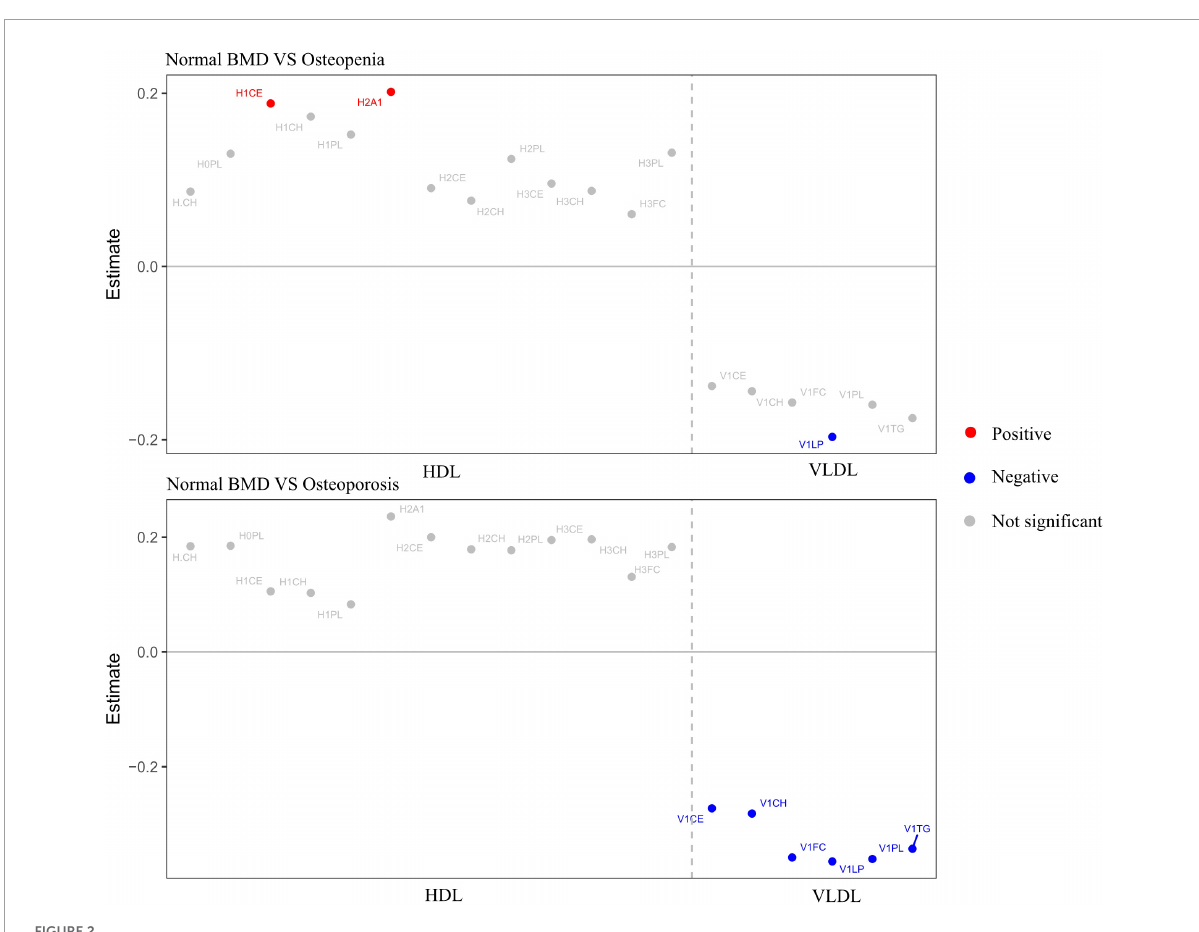
FIGURE2 Metabolites with significant differences between groups. Adjusted for age, sex, WHR, and diabetes. Red dots represented positive correlation, blue dots represented negative correlation, and gray dots represented no significant correlation.